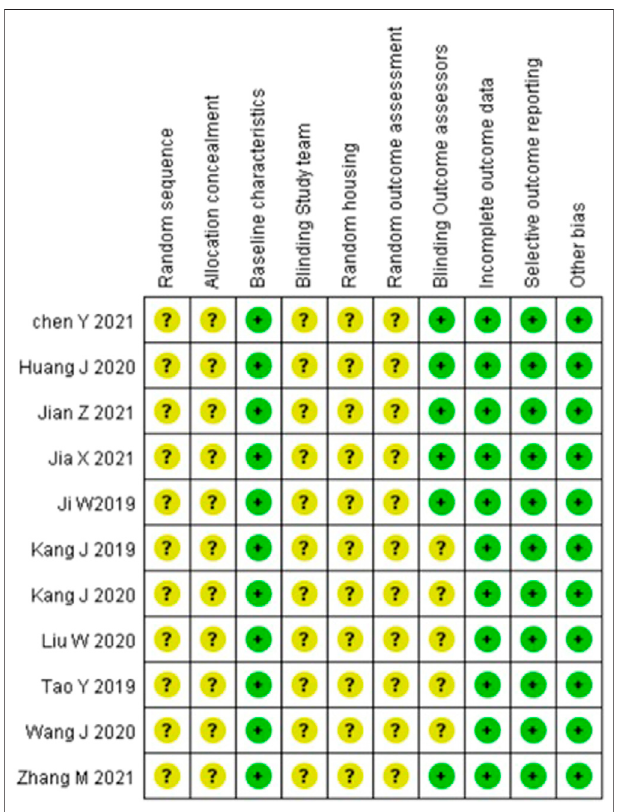
FIGURE 3 | Article quality assessment using SYRCLE ’ s